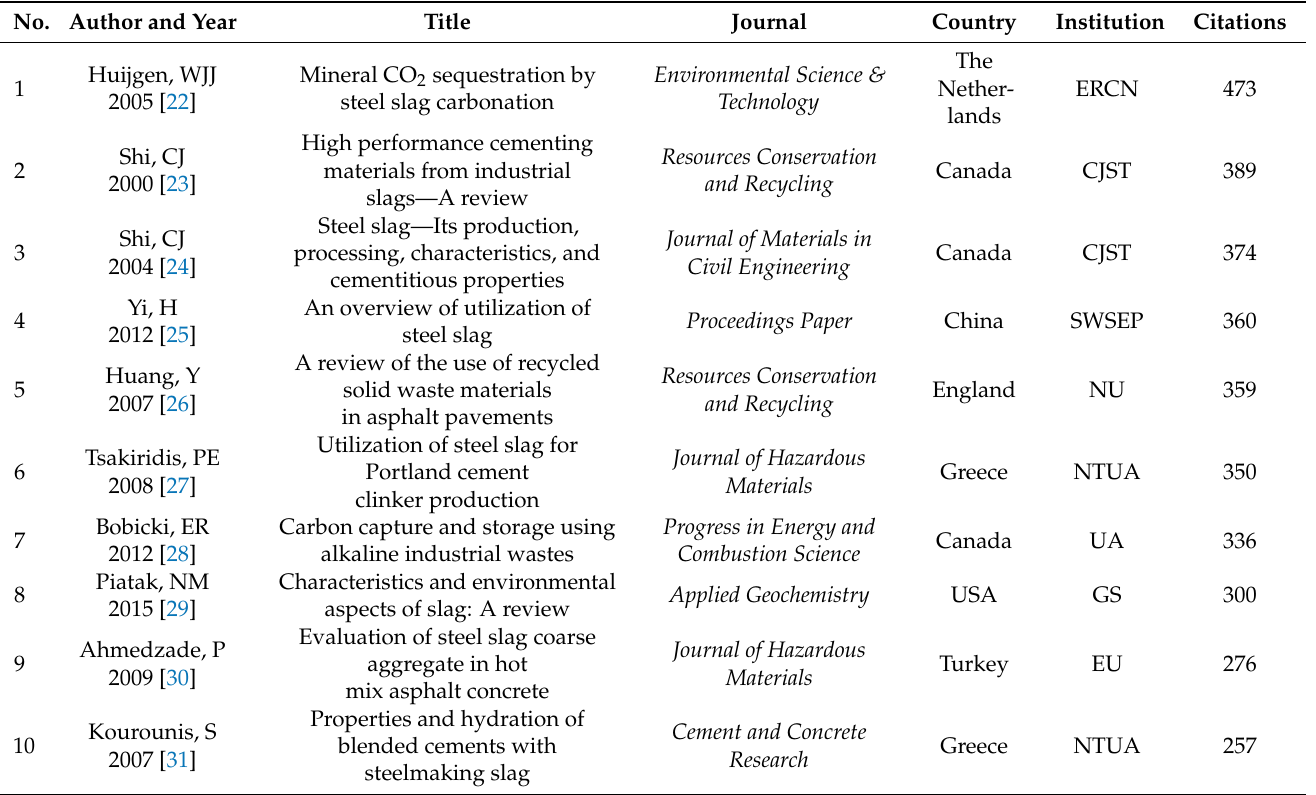
Table 2. The top 10 most cited publications in steel slag